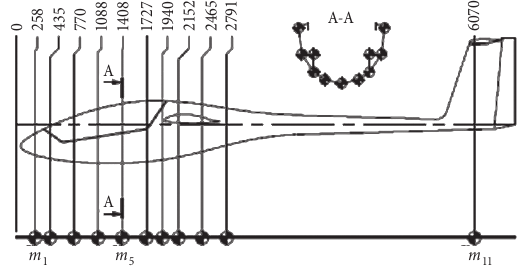
Fig. 4. Fuselage mass correction